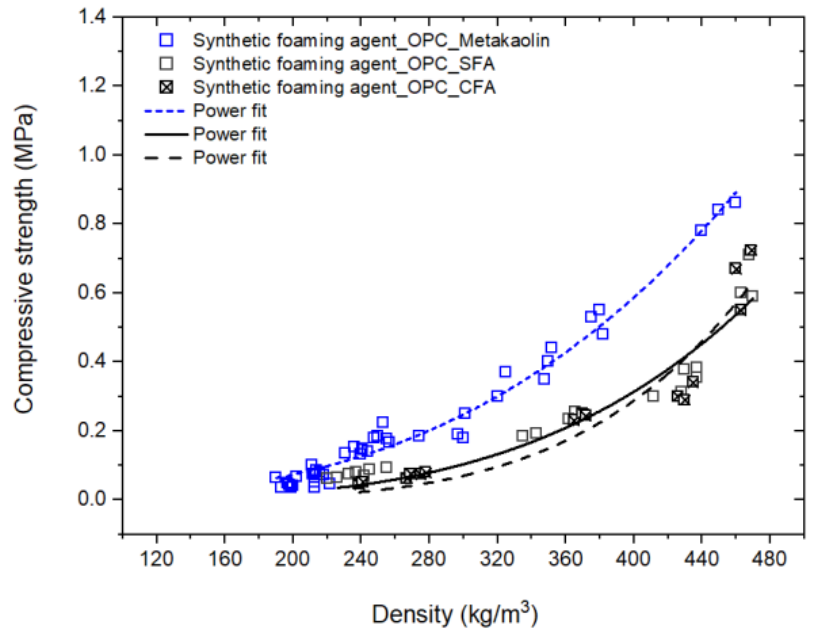
Figure 10. Compressive strength of foam concrete made of synthetic foaming agent with OPC mixed with metakaolin, or with SFA, or with CFA.